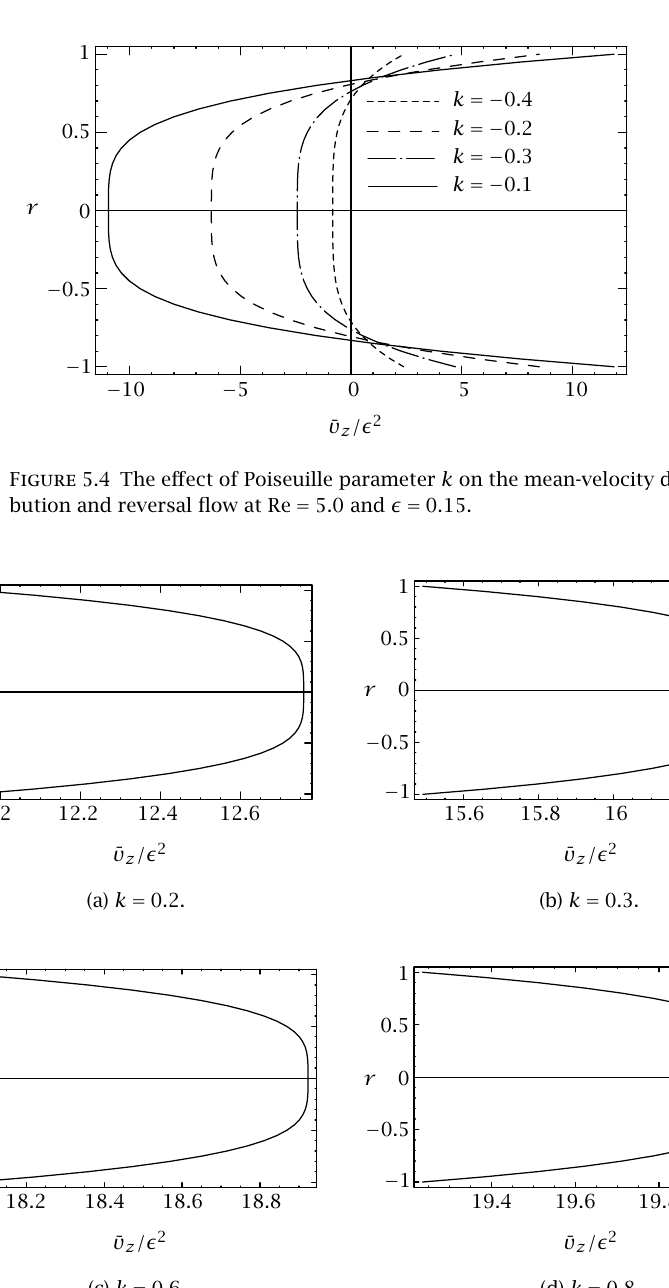
Figure 5.5 The effect of Poiseuille parameter k on the mean-velocity distri- bution and reversal flow at Re = 5 . 0, (cid:23) = 0 . 15, and (∂P/∂z) = − 3 .